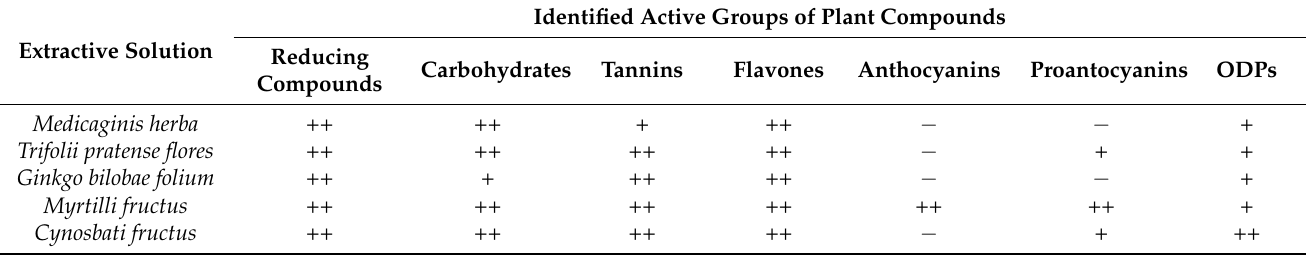
Table 3. Qualitative chemical analysis of hydroalcoholic extractive solutions. Identified Active Groups of Plant Compounds Extractive Solution